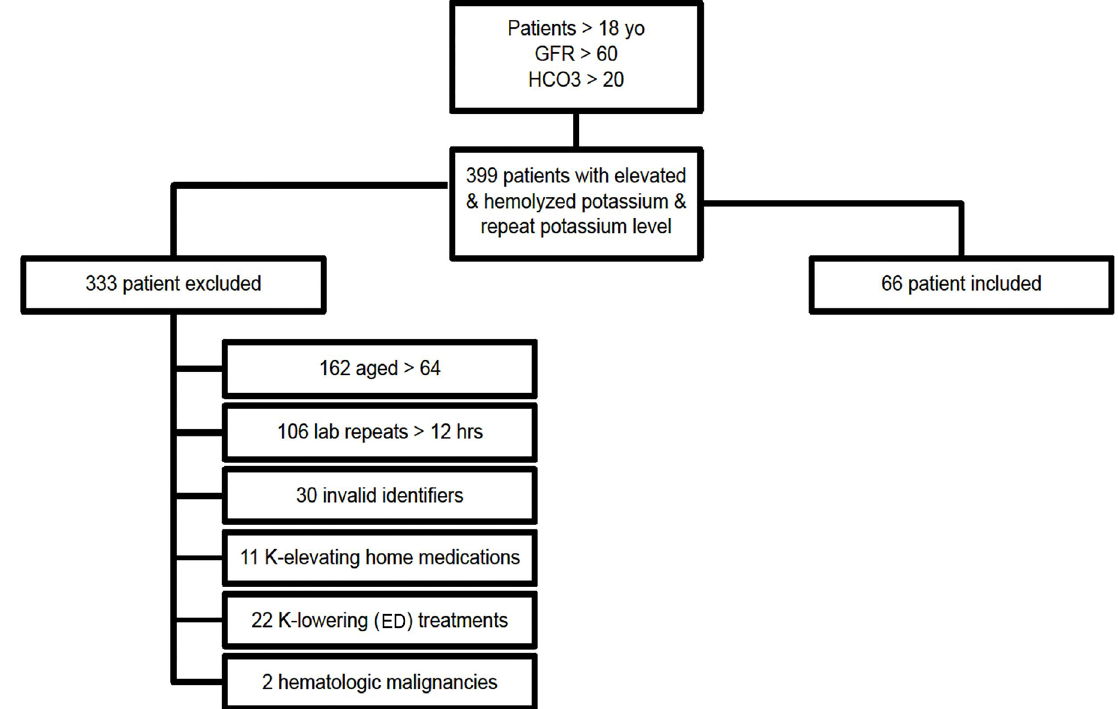
Figure 1. Inclusion flow chart demonstrating 399 patients with elevated potassium levels seen in hemolyzed lab draw. GFR , glomerular filtration rate; K , potassium; ED, emergency